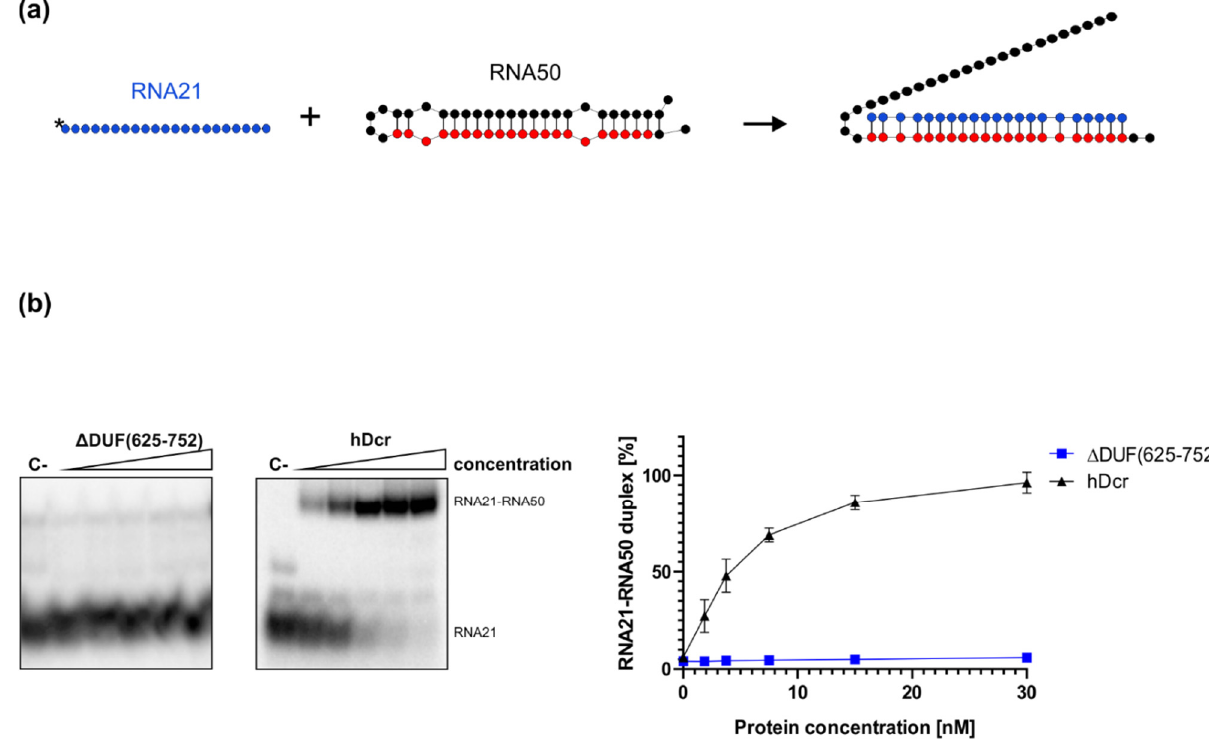
Figure 5. Annealing activity assay of ∆ DUF(625-752) and hDcr. ( a ) Schematic representation of the experiment. RNA21 (in blue) is fully complementary to the 21-nt target sequence (in red) of RNA50. ( b ) Native PAGE gel showing the results of annealing reactions carried out for 30 min and involving 1.88, 3.75, 7.5, 15, 30 nM of either ∆ DUF(625-752) or hDcr. (C-) a control incubated without the protein. The reactions were resolved in buffer containing SDS at final concentration of 0.2%. Graph presentation of the results obtained from three independent annealing assays. Error bars represent S.D. from three separate